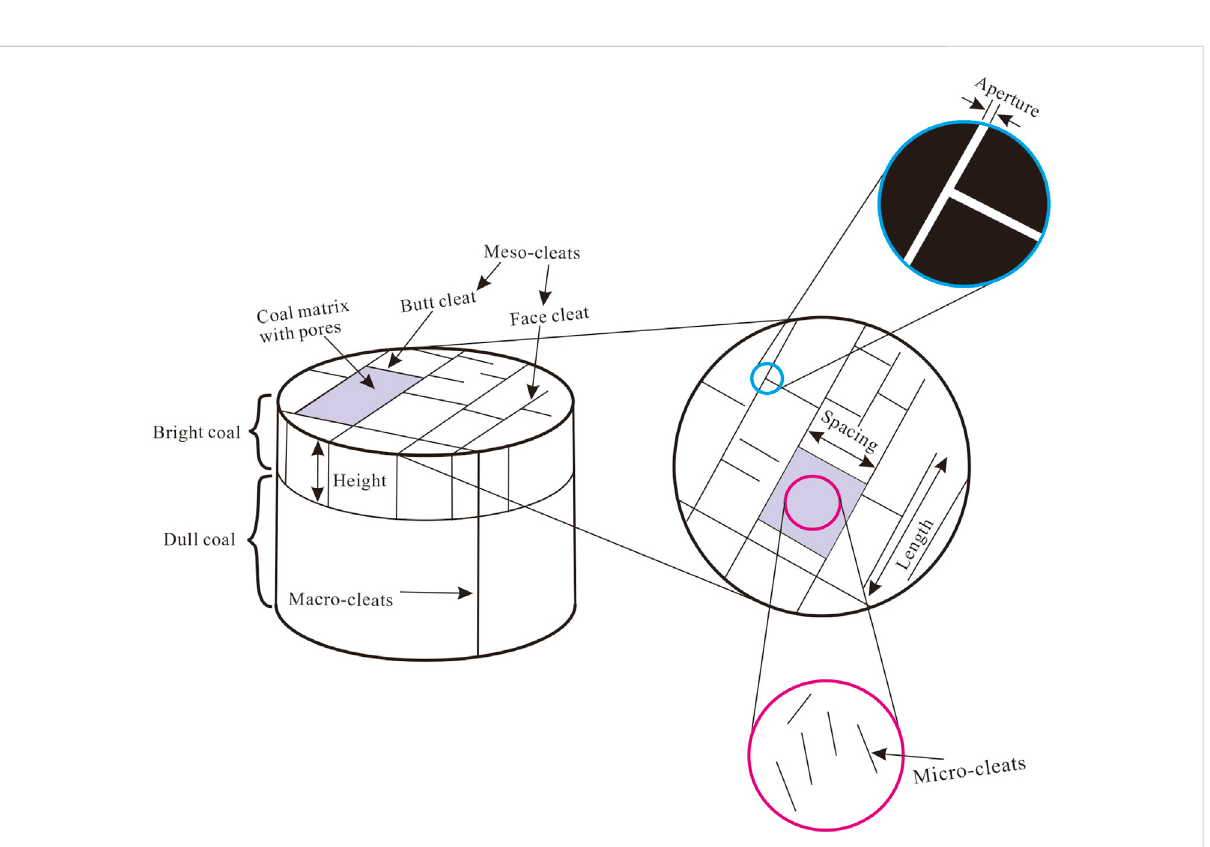
FIGURE 2 Fracture patterns in the coal (revised from Laubach et al.,